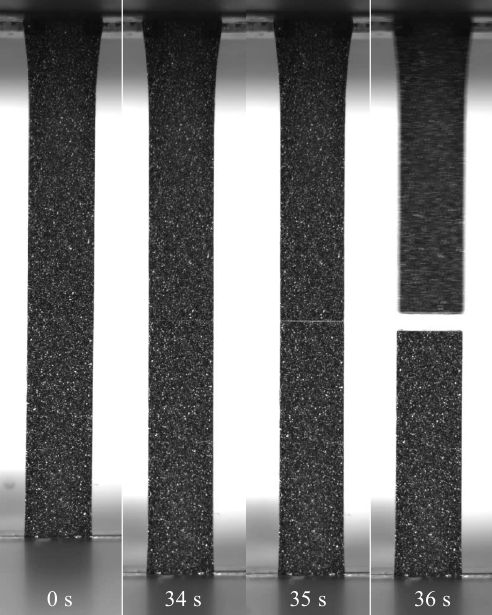
Figure 19. Deformation progression of a WL specimen of 1.8-CB/30-CC/0.25-SP under DIC.